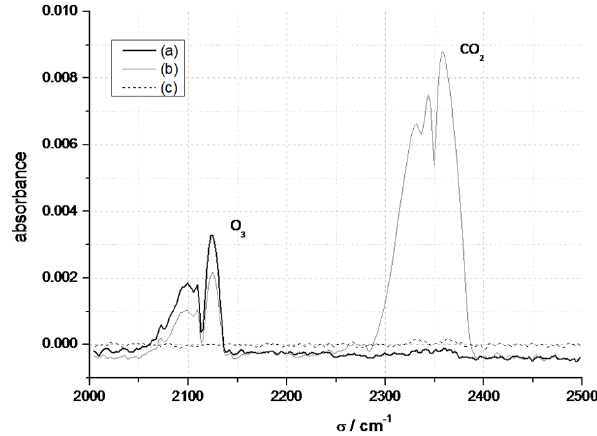
Figure 5. FTIR absorbance spectra recorded on a gaseous ozone sample at 1mbar (a) and on the same sample after 12h in the FTIR cell (b) . An absorbance spectrum recorded with 10 − 3 mbar pure CO 2 is plotted in (c) for comparison. Absorption peaks of ozone and carbon dioxide are